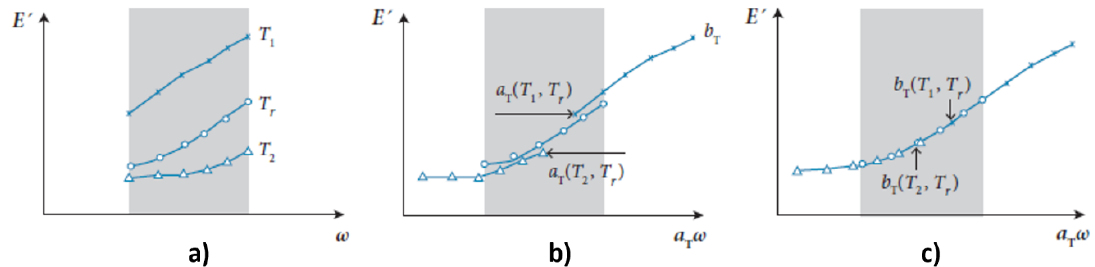
Figure 3. Determination of the frequency – temperature superposition shifting factor a T and b T : ( a ) Isotherms of storage modulus on the frequency range measurable by DMA, at temperatures T 1 , T 2 , and T r , with T 1 < T r < T 2 ; ( b ) Isotherms of storage modulus after application of the horizontal shift factors, taking Tr as the reference temperature; ( c ) Isotherms of storage modulus after application of both horizontal and vertical shift factors, taking Tr as the reference temperature [28].